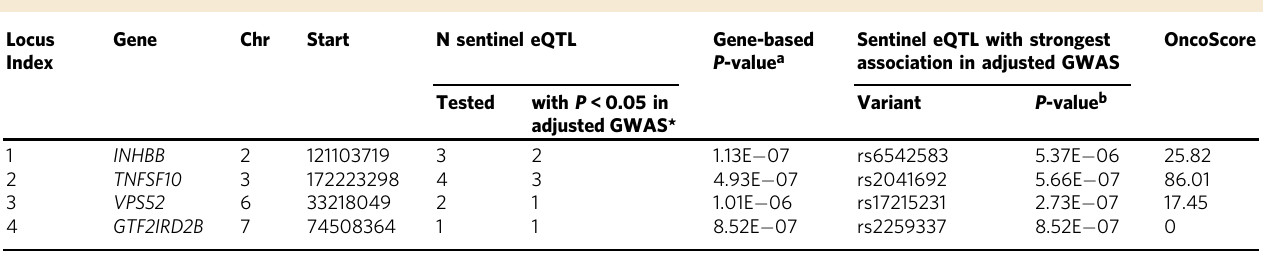
Table 5 Risk loci for ER-negative breast cancer identi fi ed in the EUGENE gene-based analysis and not in previous